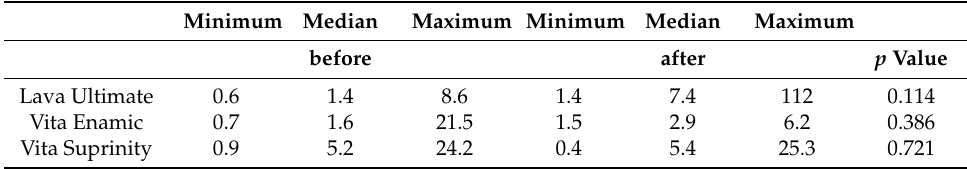
Table 1. Descriptive analysis of the asfc values and results of the Mann-Whitney U test comparing the full ceramic computer-aided design/computer-aided manufacturing (CAD/CAM) crowns occlusal surface roughness in the tested material groups before and after the chewing simulation.